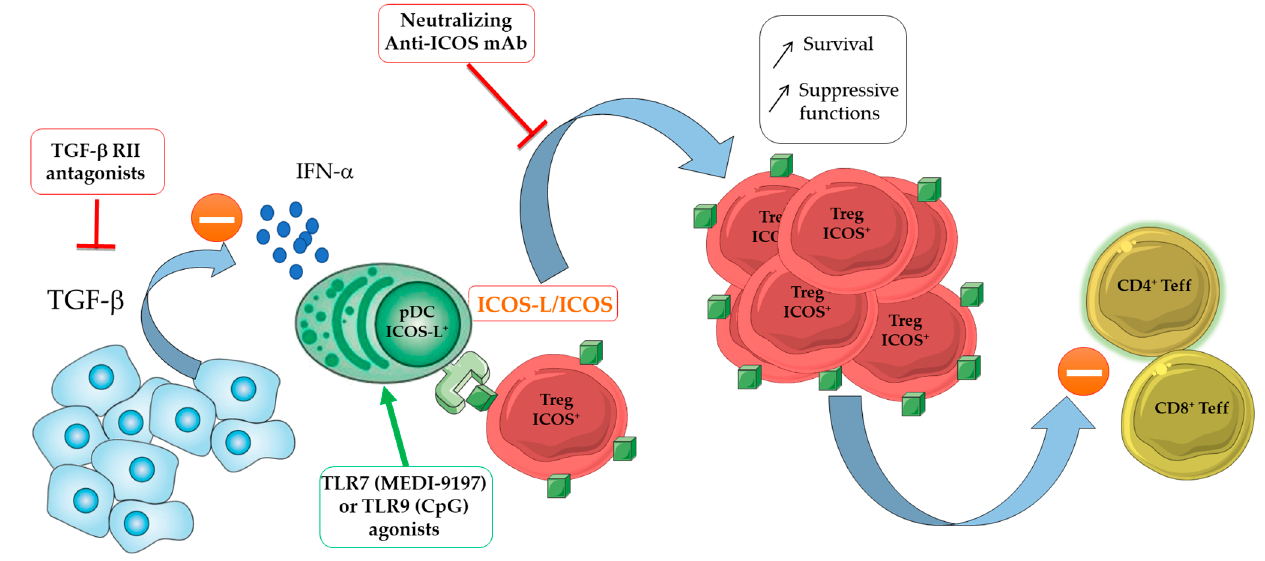
Figure 4. The TA-plasmacytoid DC (pDC)/Treg interaction is at the center of the immunosuppressive network in the breast TME. pDC capacity to secrete type-I IFN (IFN- α ) is altered by TGF- β produced in the TME. The interaction between pDC and Tregs through ICOS/ICOS-L favors the expansion and survival of Tregs that is amplified by the absence of type-I IFN. These TA-Tregs inhibit the functionality of tumor-infiltrating CD4 + and CD8 + Teff. Therapeutic strategies with TGF β -RII antagonists, neutralizing anti-hICOS mAbs, TLR7 or TLR9 agonists or their combination could reduce this immunosuppressive network.